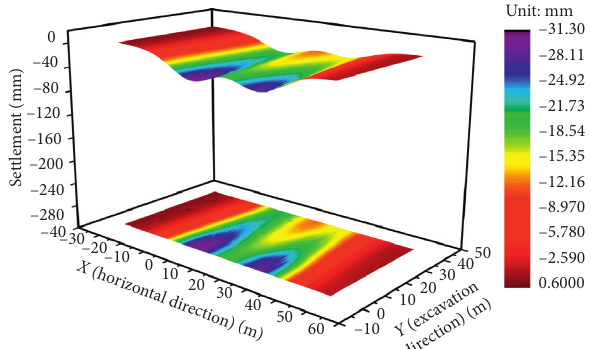
Figure 29: Surface settlement distribution after construction (with